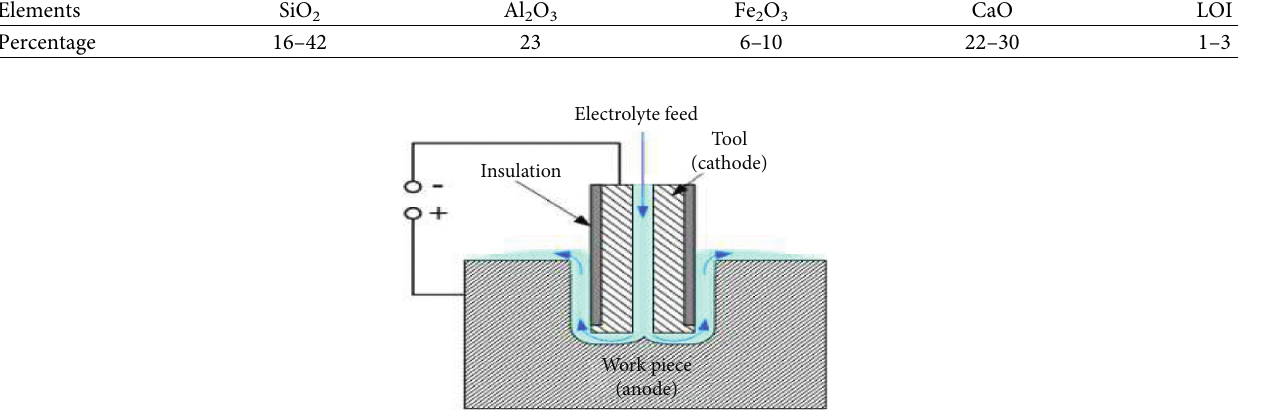
Figure 1: Electrochemical machining setup. Table 3: Parameters of machining (four levels).